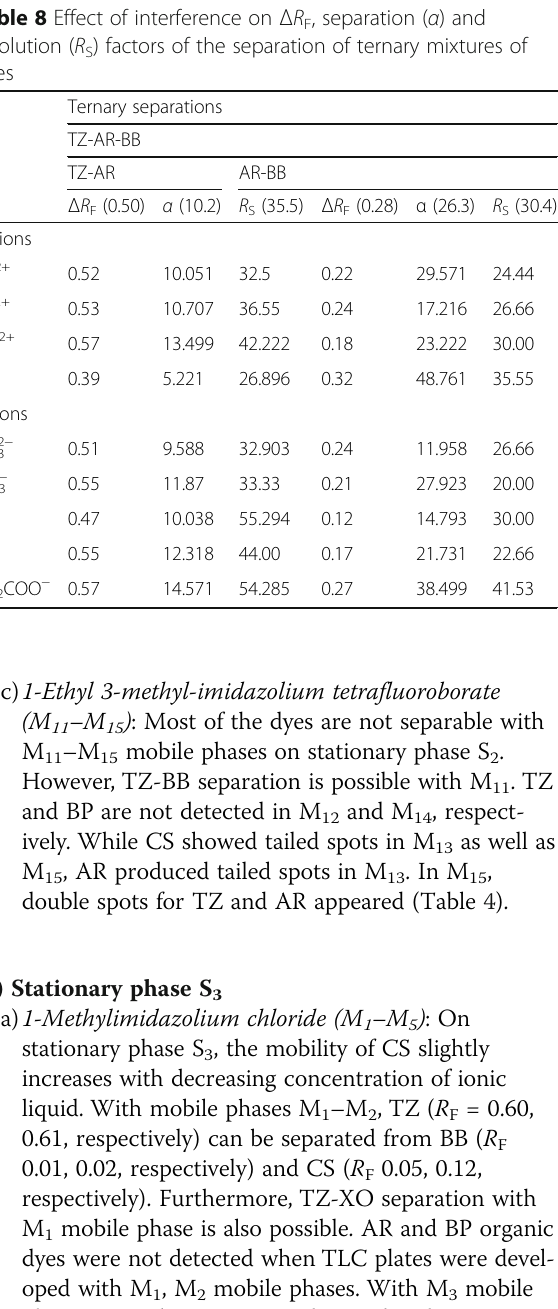
the point of application. On S